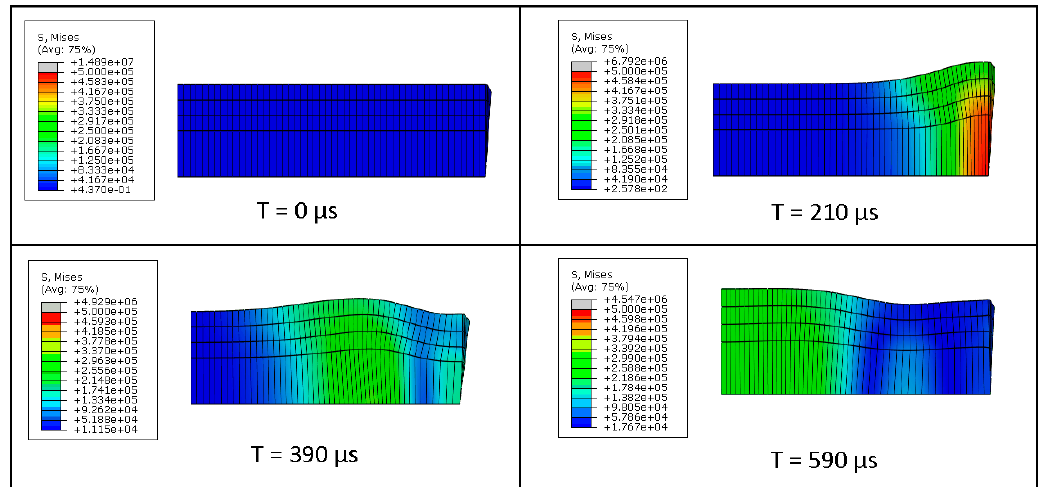
Figure 7. Deformation of a specimen with a thickness of 20 mm during the loading.